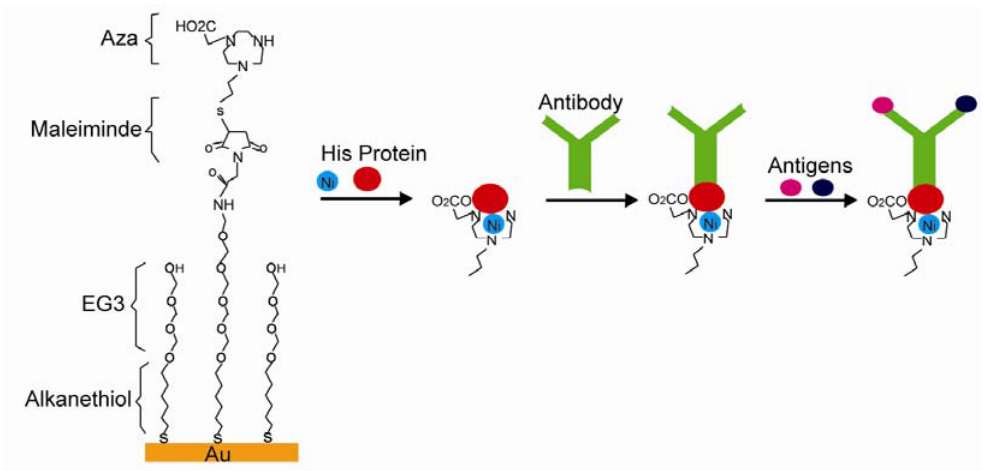
Figure 11. The application of non-covalent bonding in a SAM immunoassay (adapted from [89]).